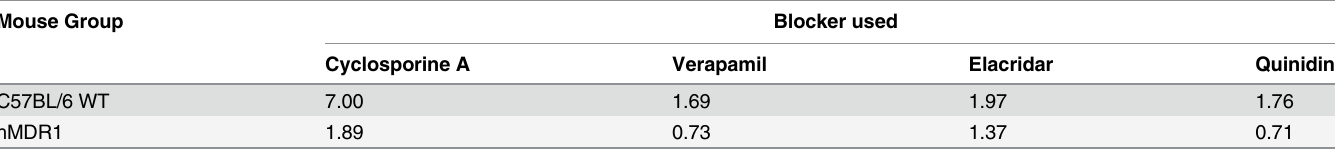
As shown in Table 5, the hMDR1 protein was observed in the isolated brain capillaries from hMDR1 mice, with protein levels 62.8-fold smaller than those of Mdr1a in C57BL/6 WT mice. When compared to the reported data of QTAP analysis in human brain microvessels [1], the Table 3. The ratio * of K p with blocker/K p in control mice for digoxin, representing a difference in the effect of the blockers between C57BL/6 WT and hMDR1 mice. Mouse Group